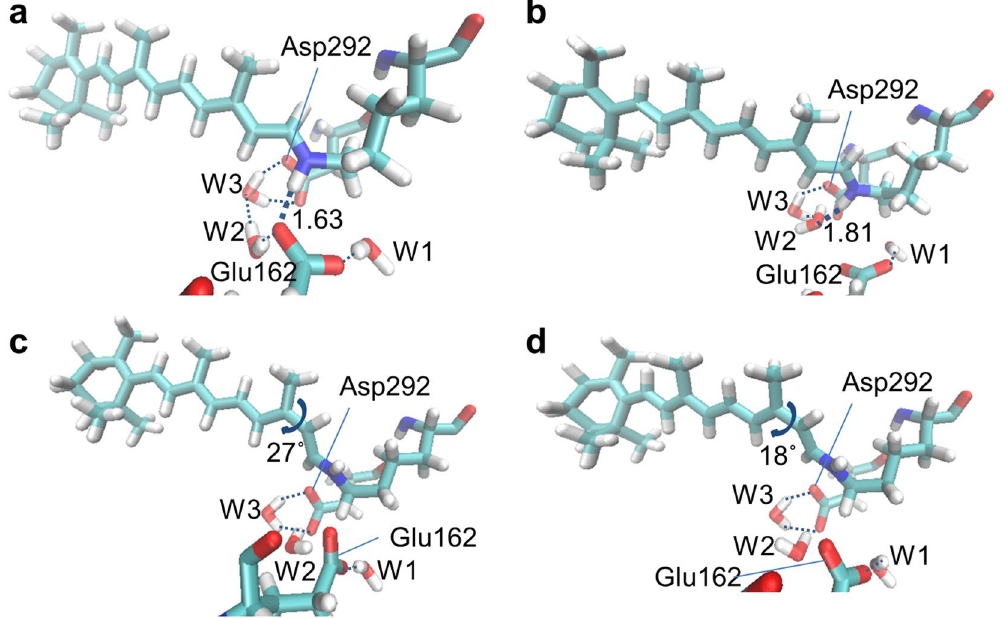
Figure 5. Calculated ground state minima structures. ( a,b ) all- trans and ( c,d ) 13- cis retinal-bound C1C2 active sites, including two possible hydrogen bonds to the retinal Schiff base for the all- trans conformations: to ( a ) Glu162 and to ( b ) a water molecule,